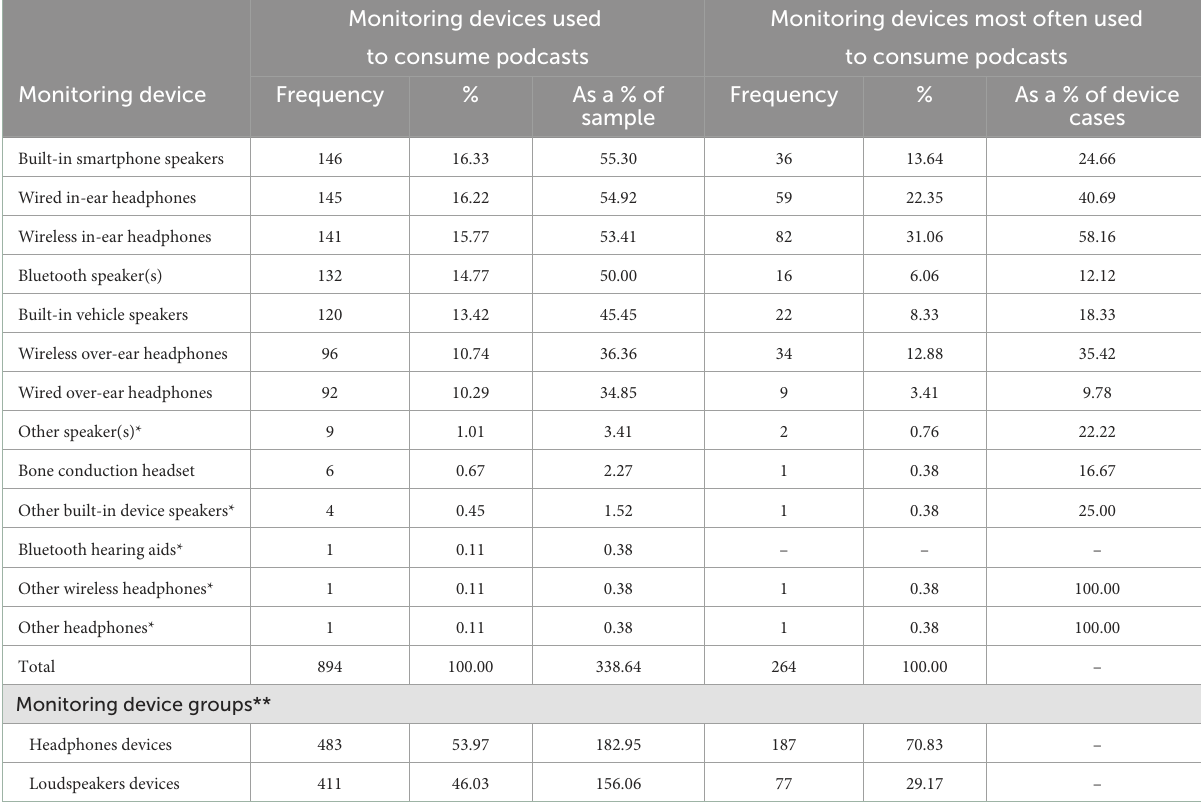
TABLE 5 Monitoring devices participants have used ( N = 264) and most often use ( N = 264) to consume podcasts with a